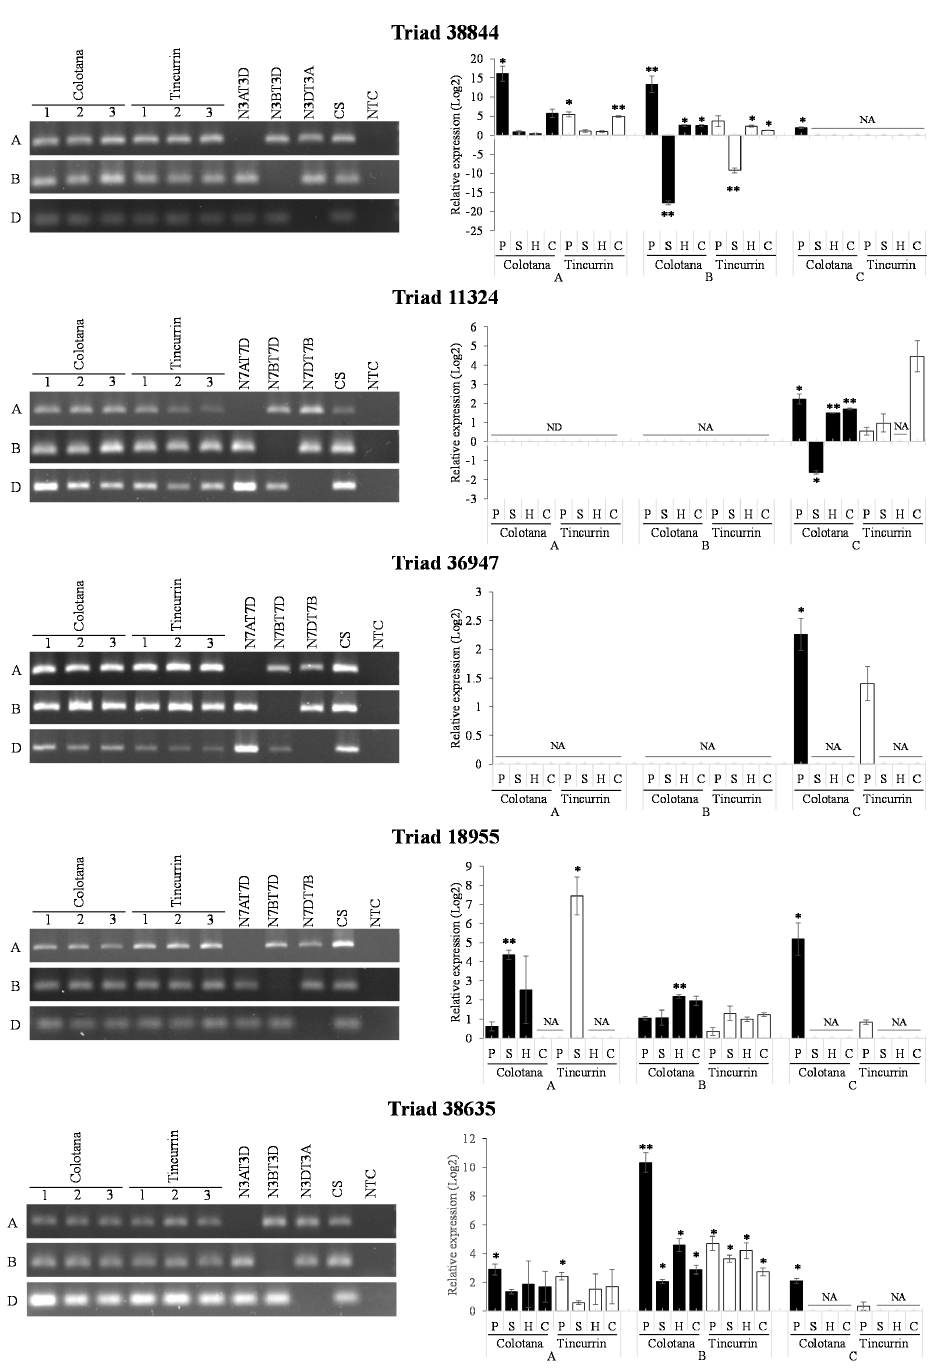
Figure 5. Comparison of di ff erentially expressed A, B, and D homoeologous genes under abiotic stresses. Validation of expression divergence of homoeologous genes using qRT-PCR. PCR validation of qRT-PCR confirmed homoeologous genes using homoeolog-specific primers. The results of PCR experiments further confirmed the localization of homoeologous genes in their corresponding subgenomes. Student’s t-test was used to assess the significance of di ff erences from control samples, * p < 0.05, ** p < 0.01. Each experiment was performed using Colotana and Tincurrin with three biological replicates. Chinese Spring (CS) was used as positive control, all reagents without template DNA as negative control (NTC). PEG-induced water stress: P; high-salinity stress: S; heat stress: H; cold stress: C; no data: ND; and no amplification: